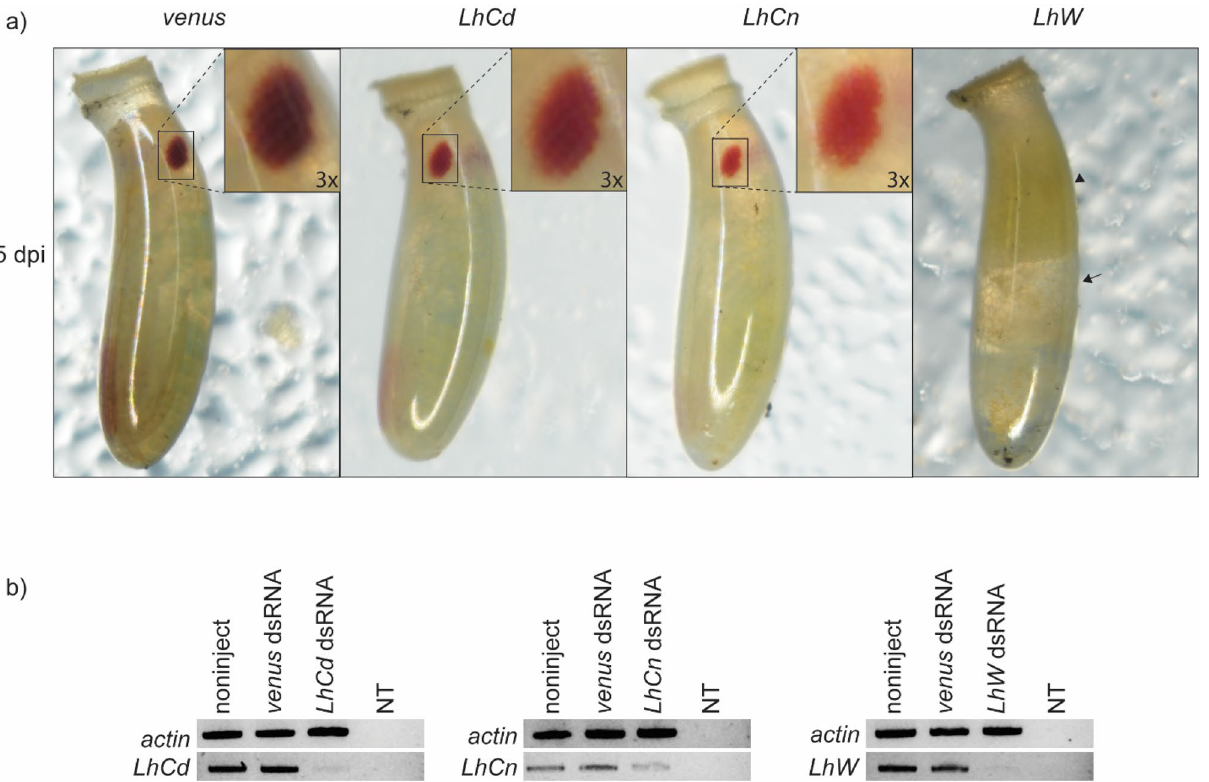
Figure 2. RNA interference knockdown of embryonic eye pigment genes. ( a ) Lygus hesperus embryos at five days post-injection (dpi) with dsRNA for venus , LhCd , LhCn , or LhW . Embryos injected with dsRNA corresponding to LhW were lethal and resulted in no accumulation of eye pigmentation. Inset shows 3 × magnification of the eyes. Arrowhead and arrow indicate the undeveloped and unorganized but developed parts of the LhW dsRNA injected egg, respectively. ( b ) Semi-quantification of knockdown in LhCd , LhCn , and LhW transcripts. Gel images of transcript knockdown are representative of four technical replicates and three biological replicates. No template